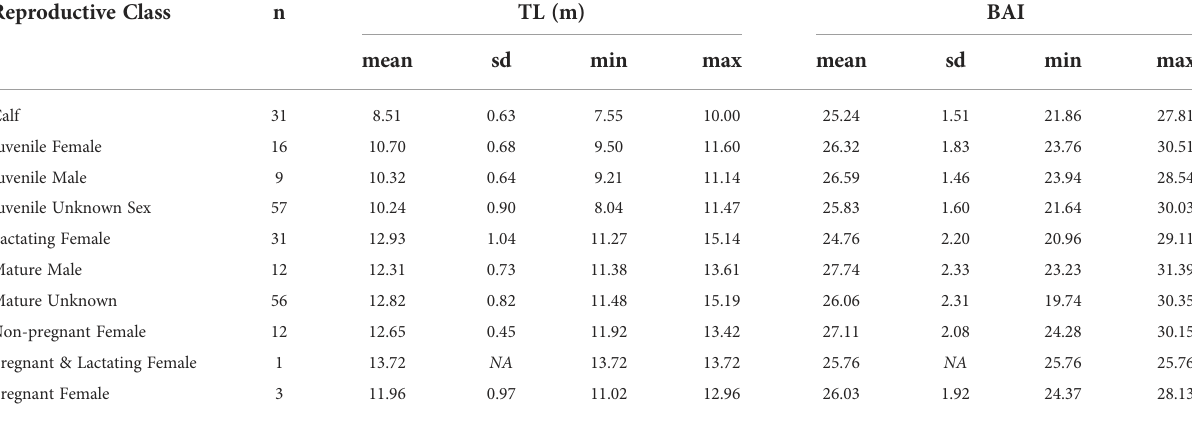
TABLE 2 Summary statistics of the total length (TL) and Body Area Index (BAI) for each reproductive class. Reproductive Class